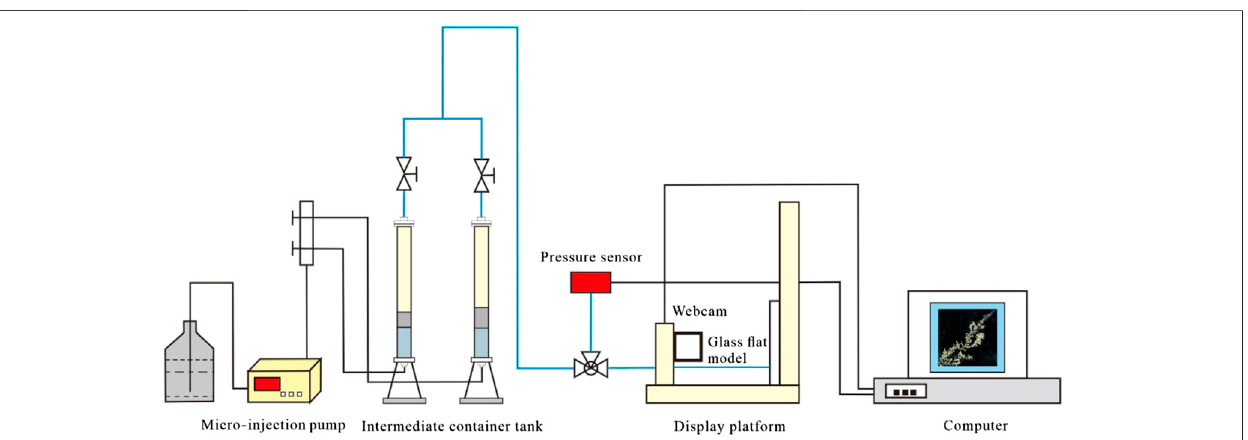
FIGURE 3 | Visualization glass plate experimental instrument connection and oil-displacement